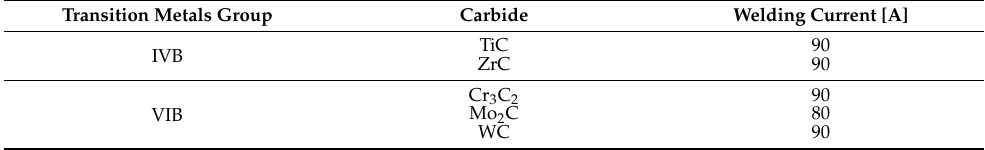
Table 4. Welding current values used to produce overwelds for comparative